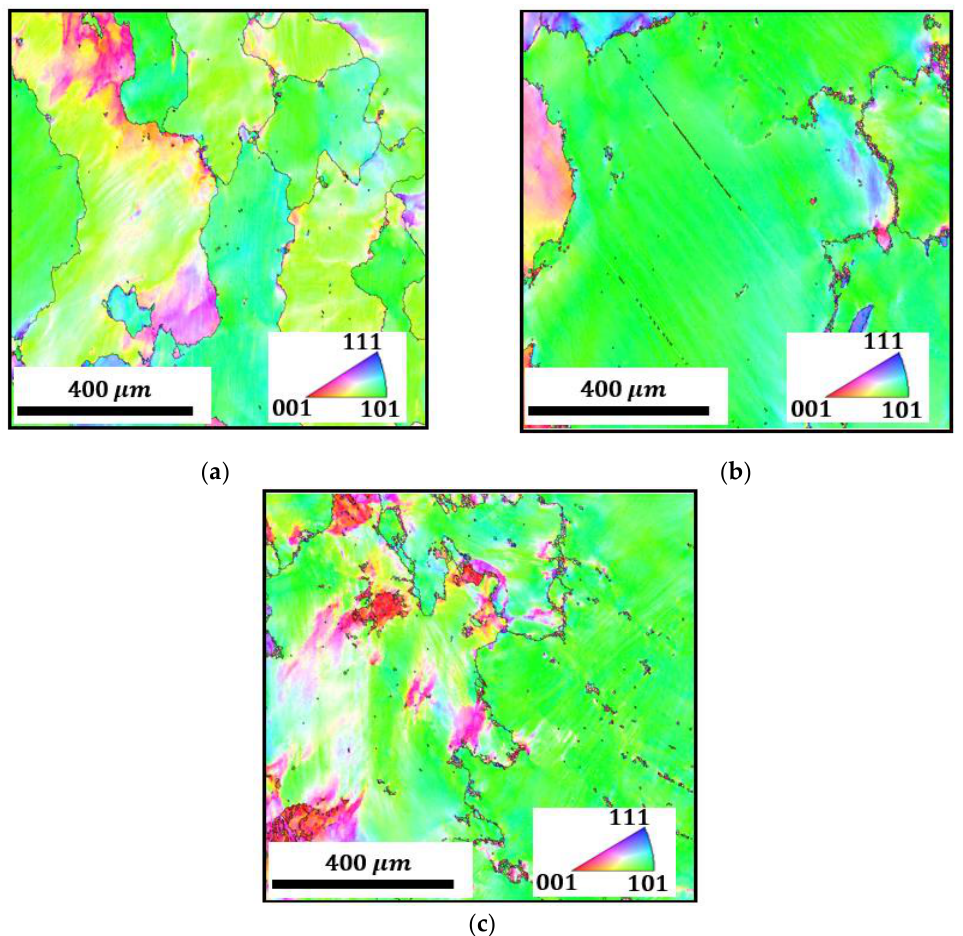
Figure 5. EBSD microstructure observations of different conditions: ( a ) 1000 °C – 0.01/s – 0.2; ( b ) 1000